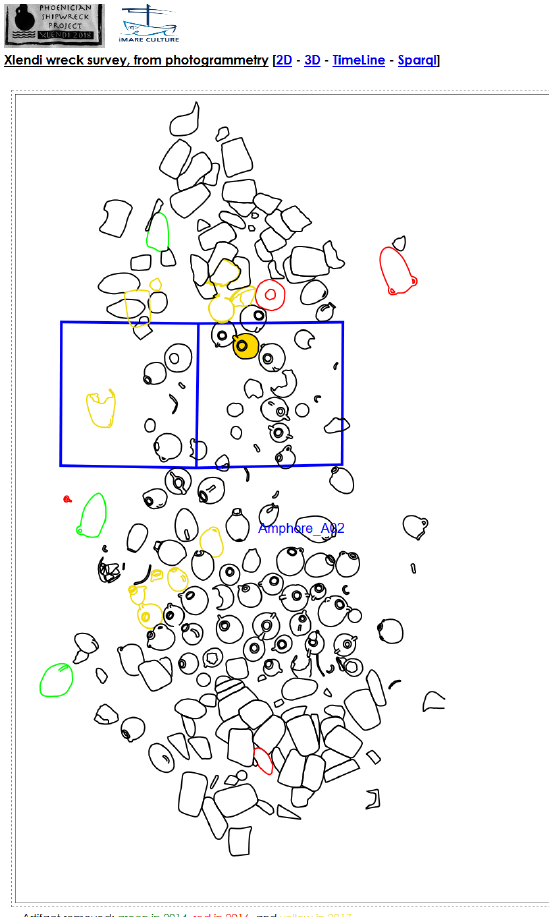
Figure 4: Xlendi Orthophoto drawing in our 2D Web tool (pow- ered by Rapha¨el 16